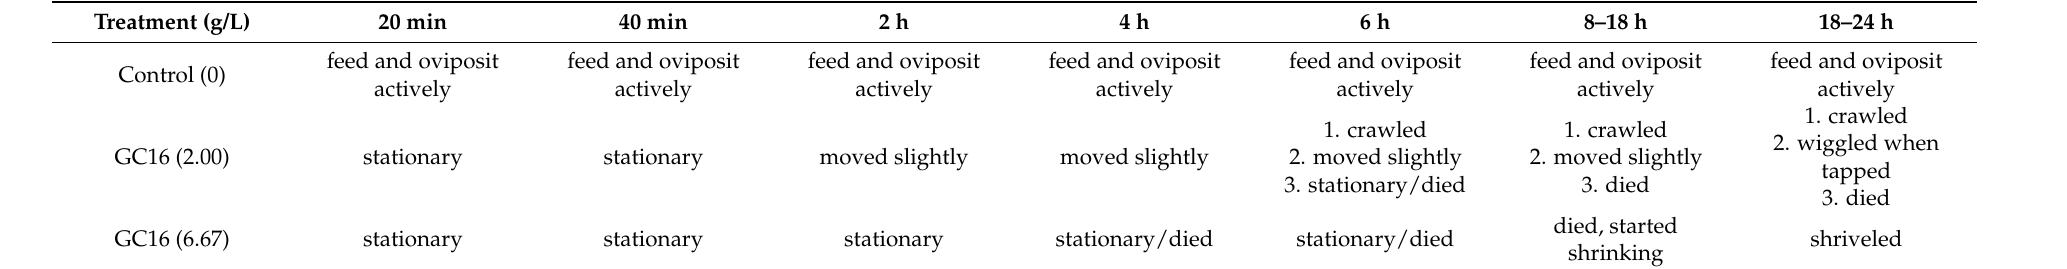
Table 2. Poisoning symptoms after the GC16